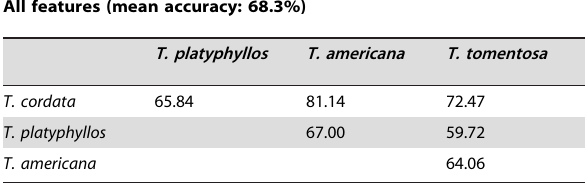
Comparison of LDA (linear discriminant analysis) classification accuracy of each pairwise model. The list of ‘‘tooth related’’ and ‘‘non-tooth related’’ features is given in Table 2. Two-tailed t -tests show that the mean accuracy of each of the three feature sets is significantly higher than the previous set, or significantly higher than a random classifier in the first case ( p & 0 in all cases).